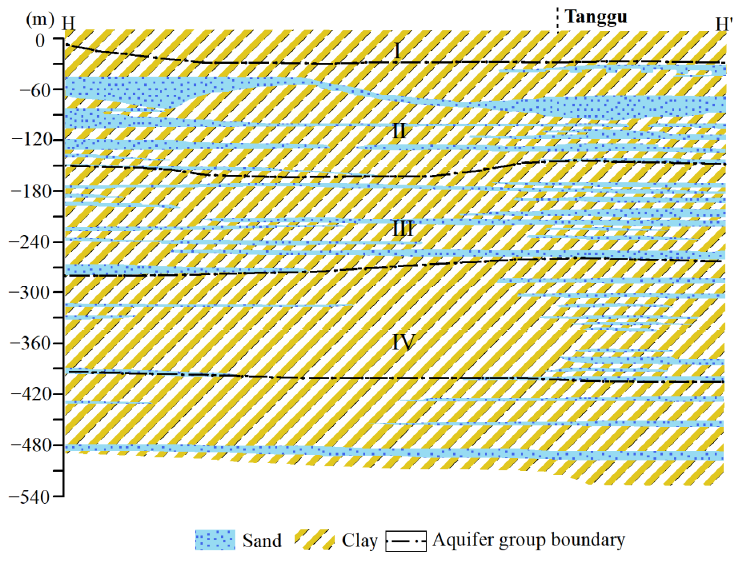
Figure 2. Hydrogeological cross-section in the study area. The black dashed line represents the aquifer group boundary (modified from